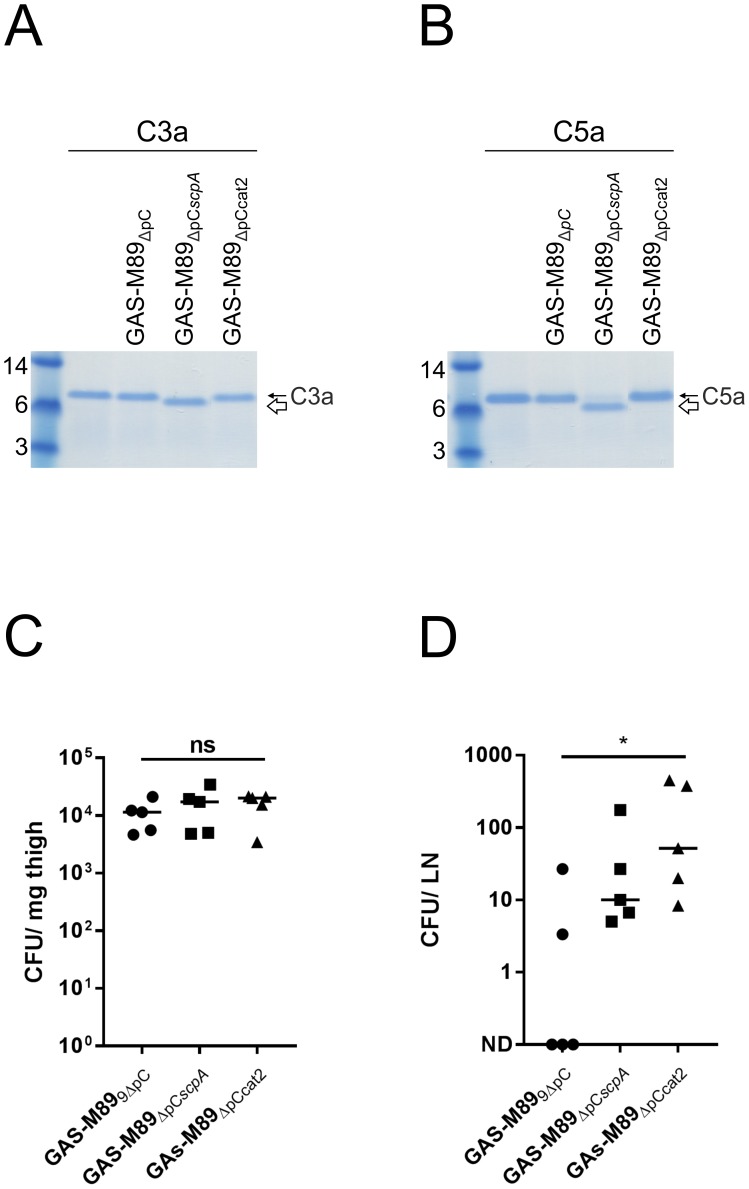
Catalytic activity of ScpA is not required for pathogenesis in vivo.A+B) Cleavage of human complement factors A) C3a and B) C5a by whole cell pellets (4x106 cfu) of GAS-M89ΔpC, GAS-M89ΔpCscpA and GAS-M89ΔpCcat2. Only strain GAS-M89ΔpCscpA, expressing catalytically active ScpA was able to cleave either complement factor. Cleaved moieties (C3ascpA and C5ascpA) are indicated by a white arrow in each panel. C+D) Characterization of GAS-M89ΔpC, GAS-M89ΔpCscpA and GAS-M89ΔpCcat2 dissemination in a murine model of soft tissue infection in wildtype CD57/BL6 mice (n = 5/group). Quantitative culture of tissue homogenates (C) from the site of infection (thigh) to (D) the draining inguinal lymph node (LN). Line depicts median value. (Mann Whitney U, No difference (ns) = p>0.05, * = p<0.05).